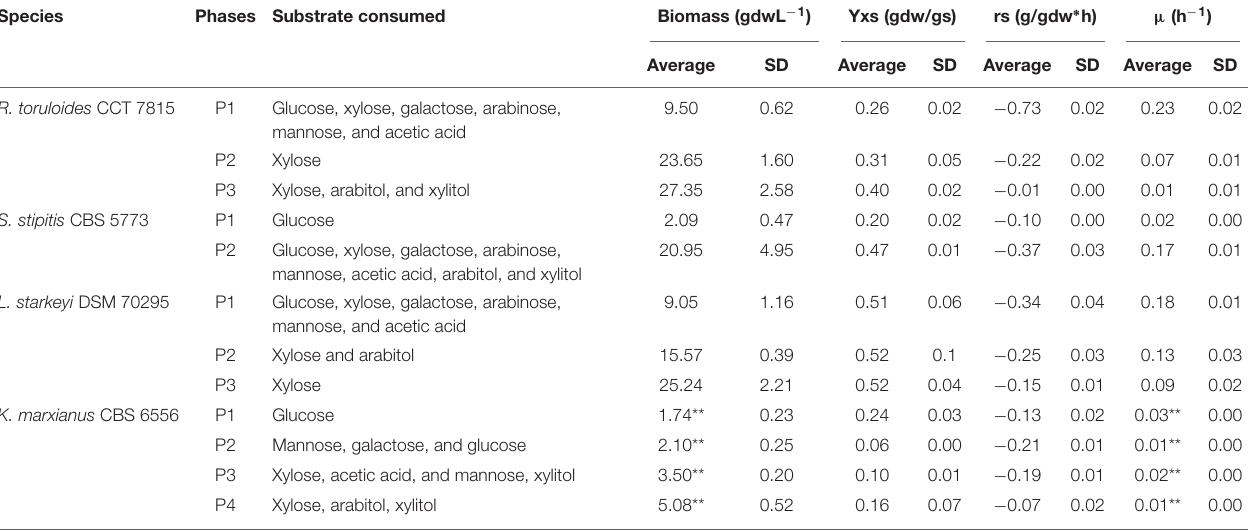
TABLE 1 | Yields and specific rates calculated from the cultivation of R. toruloides CCT 7815, S. stipitis CBS 5773, L. starkeyi DSM 70295, and K. marxianus CBS 6556 with hemicellulosic hydrolysate C5-Birch. Species Phases Substrate